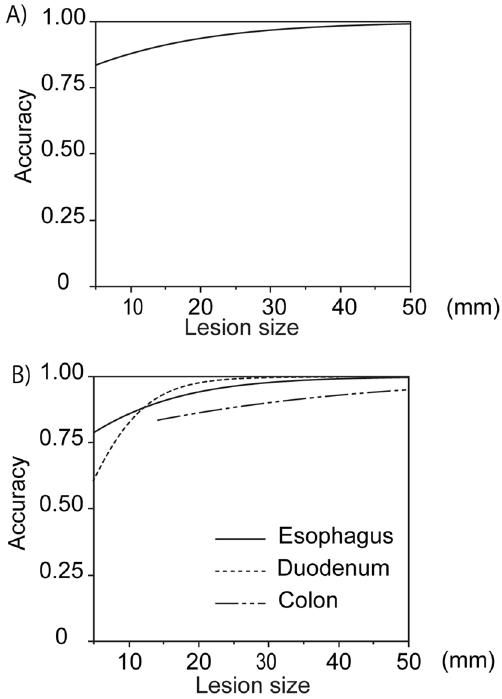
Figure 2. Relationship between the diagnostic ability of EUS-AI for non-gastric GISTs and lesion size. ( A , B ) The relationship between the diagnostic accuracy of EUS-AI and lesion size in the 52 cases with non- gastric SELs ( A ), and in each part of the gastrointestinal tract (esophagus; n = 15, duodenum; n = 26, colon; n = 11) ( B ) was examined using a logistic regression model. The concordance rates between the diagnoses of the abovementioned conditions and pathological results were determined. The cases with colorectal SELs had missing values between 0 and 12 mm because of the insufficient number of cases. EUS-AI,